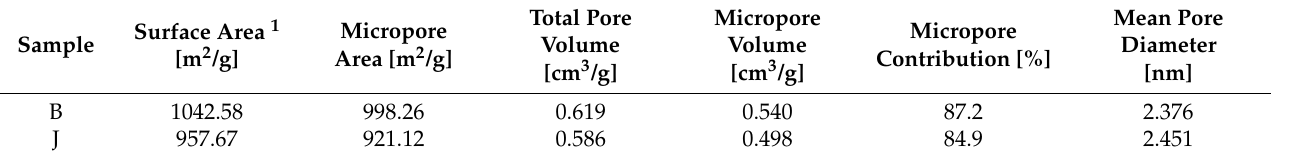
Table 1. Textural parameters of the carbonaceous materials derived from the used carbon filters.